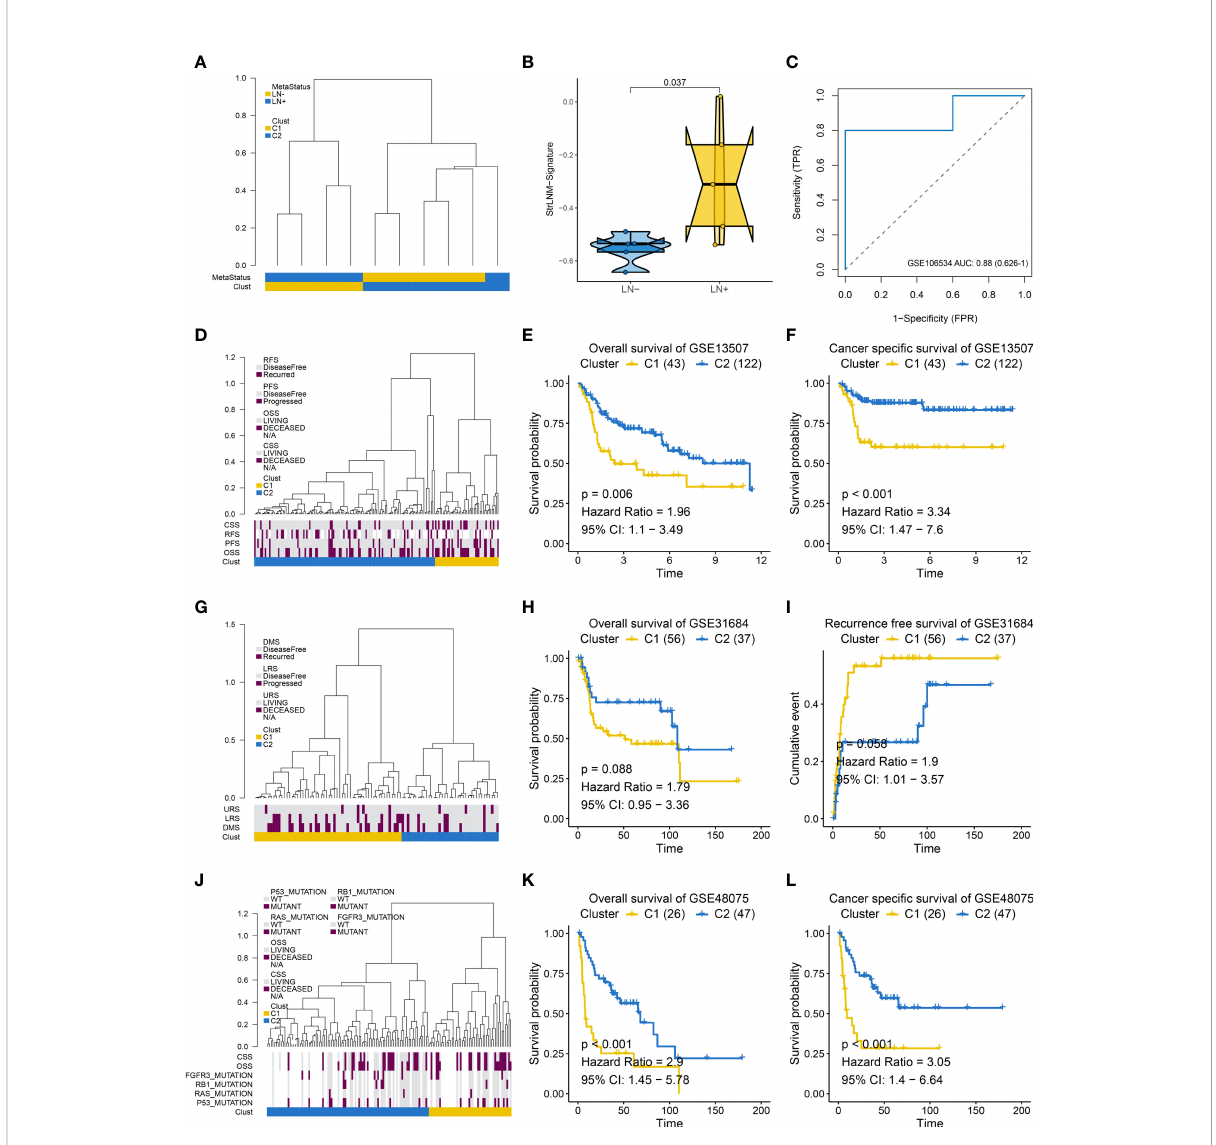
FIGURE 4 Supervised hierarchical clustering for EMT-LN signature. (A) Dendrogram showed that two clusters created by supervised hierarchical clustering could signi fi cantly distinguish LN metastasis status in the GSE106534 cohort. (B) different StrLNM signature score in LN+ and LN- patients. (C) ROC curves of StrLNM signature score in the GSE106534 cohort. (D) Dendrogram showed that two clusters created by supervised hierarchical clustering were strikingly associated with OS, RFS, and CSS in the GSE13507 cohort. (E, F) Kaplan-Meier survival curves showed the difference in OS (log-rank test, p =0.006, E ) and CSS (log-rank test, p < 0.001, F ) between LN+ and LN- tumors in the GSE13507 cohort. (G) Dendrogram showed that two clusters created by supervised hierarchical clustering were strikingly associated with disease metastasis survival (DMS), lymph node recurrence survival (LRS), and urinary tract recurrence survival (URS) in the GSE31684 cohort. (H, I) Kaplan-Meier survival curves showed the difference in OS (log-rank test, p =0.088, H ) and RFS (log-rank test, p =0.056, I ) between LN+ and LN- tumors in the GSE31684 cohort. (J) Dendrogram showed that two clusters created by supervised hierarchical clustering were strikingly associated with P53, RAS, RB1 and FGFR3 mutation as well as OS and CSS in the GSE48075 cohort. (K, L) Kaplan-Meier survival curves showed the difference in OS (log-rank test, p < 0.001, K ) and CSS (log-rank test, p < 0.001, L ) between LN+ and LN- tumors in the GSE48075